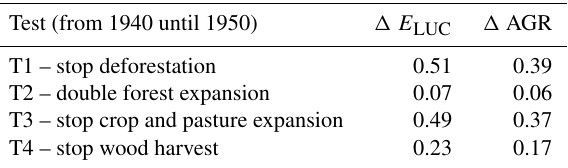
Figure 6. Response of the terrestrial ecosystems to the climate anomalies during the plateau period, simulated by the DGVMs. Temperature (left top) and precipitation (left bottom) anomaly fields during 1940–1950 (relative to 1900–1930) and the corresponding latitudinal anomaly of L DGVM estimated by each model (grey lines) and the multi-model average (right panel). Table 7. Average difference in E LUC and atmospheric CO 2 growth rate between the OSCAR standard run and the simulations us- ing different LUC hypothetical scenarios during 1940–1950, in PgCyr − 1 .